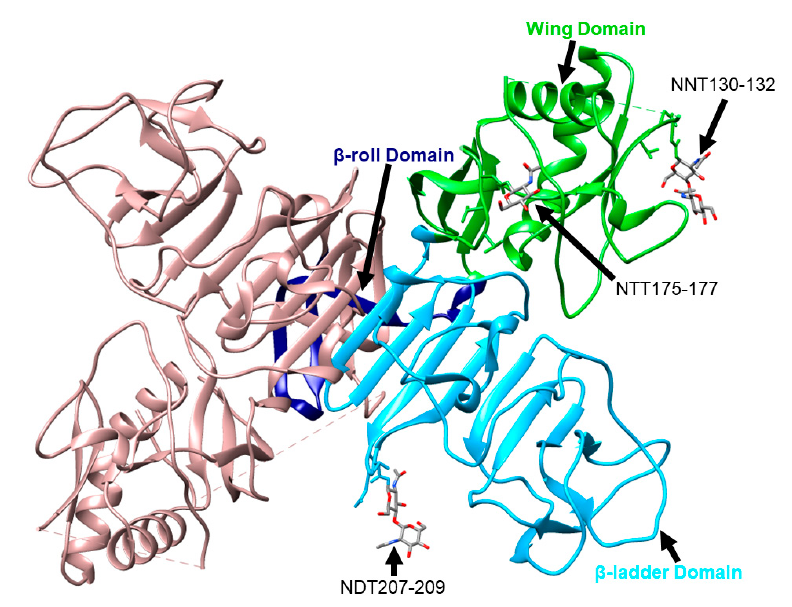
Figure 2. WNV NS1 dimer with one monomer colored in light pink and the second monomer colored as follows: β -roll (navy), wing domain (neon green), and β -ladder (light blue). The three glycosylation motifs of one monomer are included with their corresponding amino acids, residues, and N-linked glycans. This structure was colored using Chimera 1.14 and can be found at the PDB 4O6D.